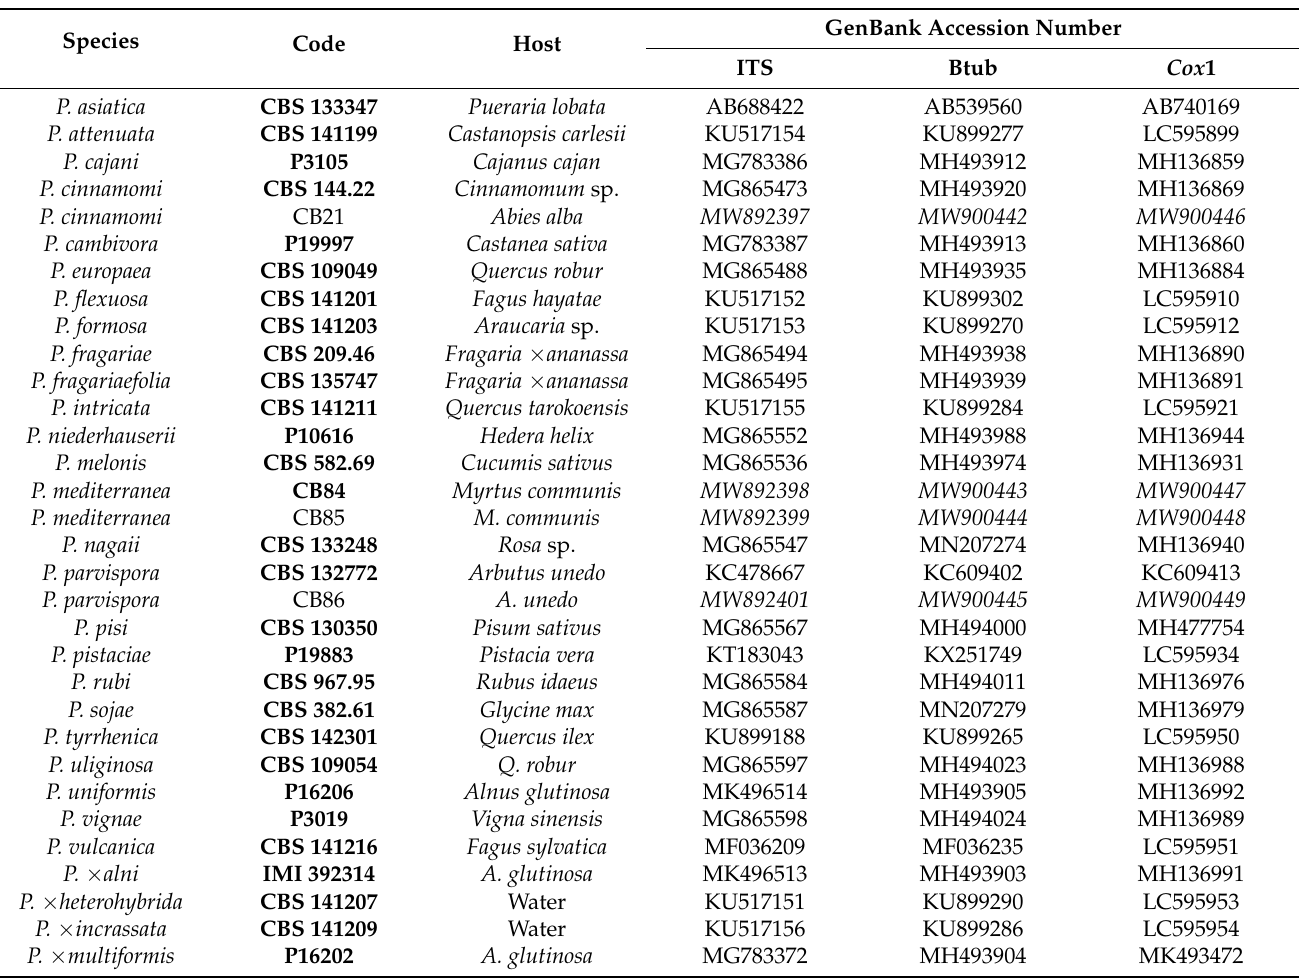
Table 2. Phytophthora isolates used in the phylogenetic analysis. Ex-type cultures are reported in bold and newly generated sequences are indicated in